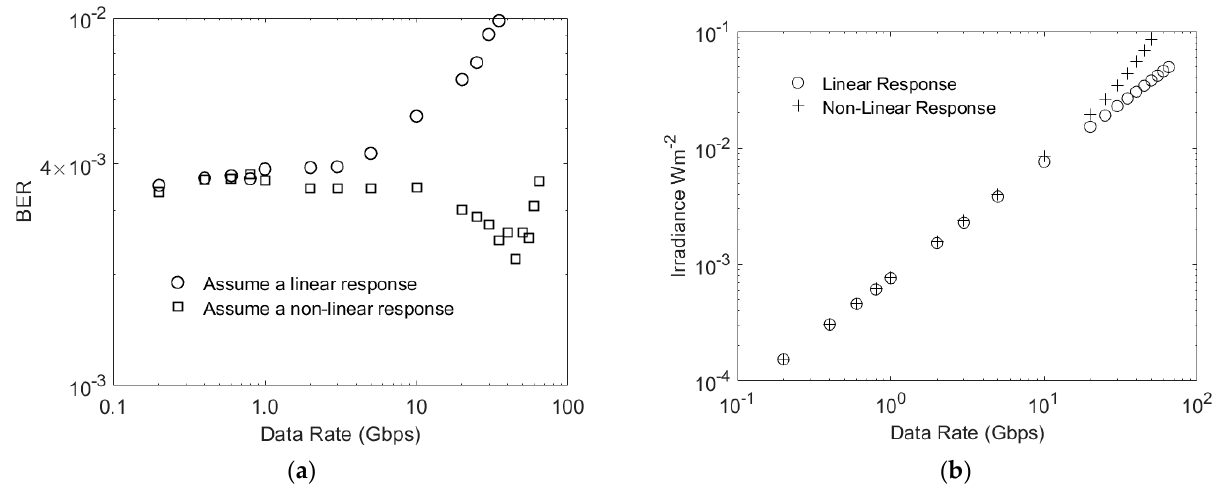
Figure 4. ( a ) The BER from a simulation that assumed a fast output pulse width of zero, and when a zero is transmitted there are no detected photons. This means that, to achieve the target BER of 3.8 × 10 − 3 , approximately 5.2 photons have to be detected. ( b ) The irradiances used to generate the re- sults in ( a